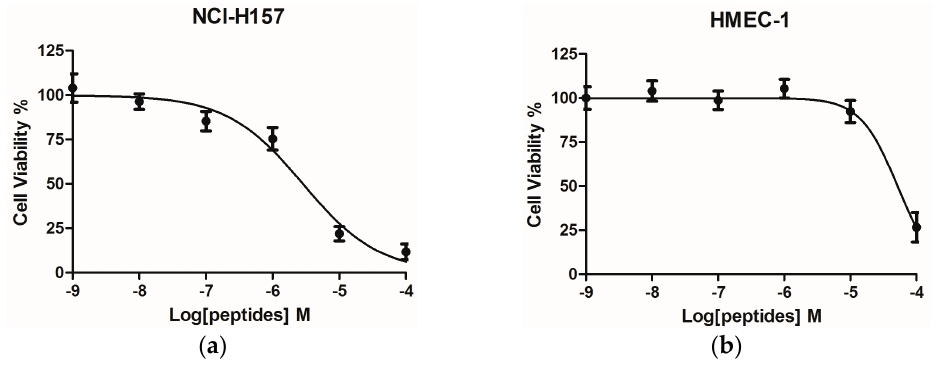
Figure 7. Dose-response curves of PSN-PC on the non-small cell lung cancer cell line NCl-H157 ( a ) and the human microvessel endothelial cell HMEC-1 ( b ) after 24 h incubation. IC 50 of NCl-H157 and HMEC-1 were 2.85 and 51.83 µM, respectively.